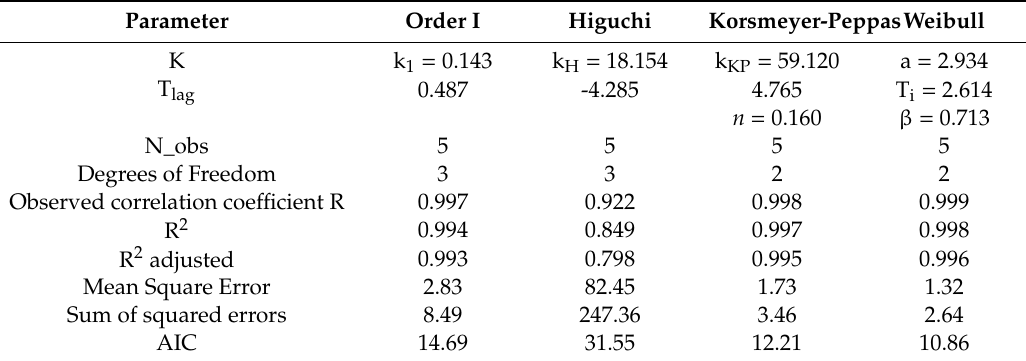
Table 2. Evaluation of the performance of the captopril release profiles in simulated saliva (Pk-Solver). AIC: Akaike Information